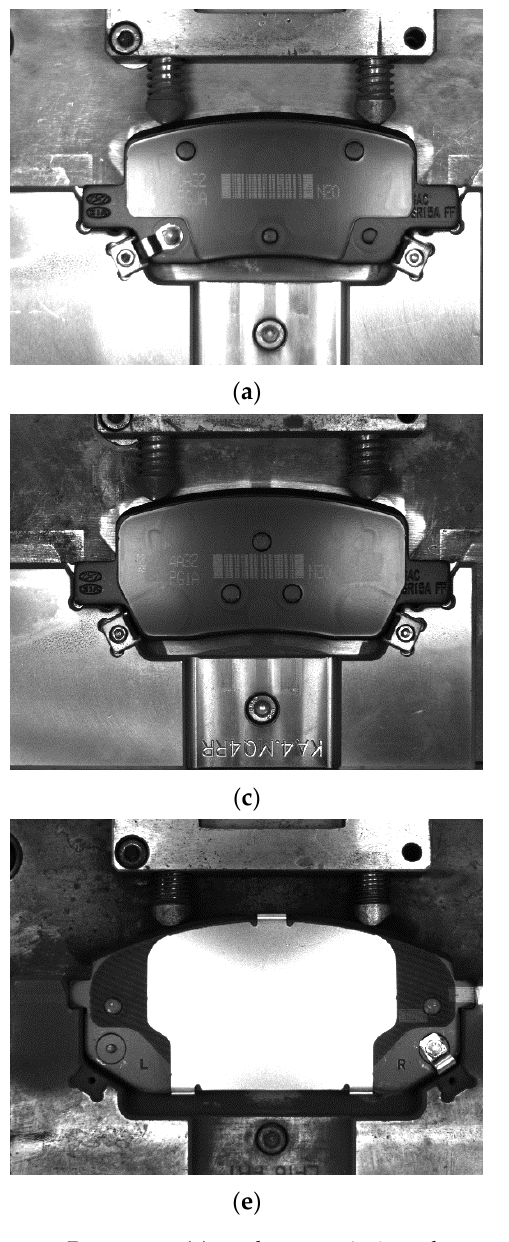
Figure 4. Data types: ( a ) product type 1, riveted sensor in left; ( b ) product type 1, unriveted sensor in right; ( c ) product type 2; ( d ) product type 3, unriveted sensor in left; ( e ) product type 3, riveted sensor in right; and ( f ) product type 4. Table 1. The number of objects to detect.